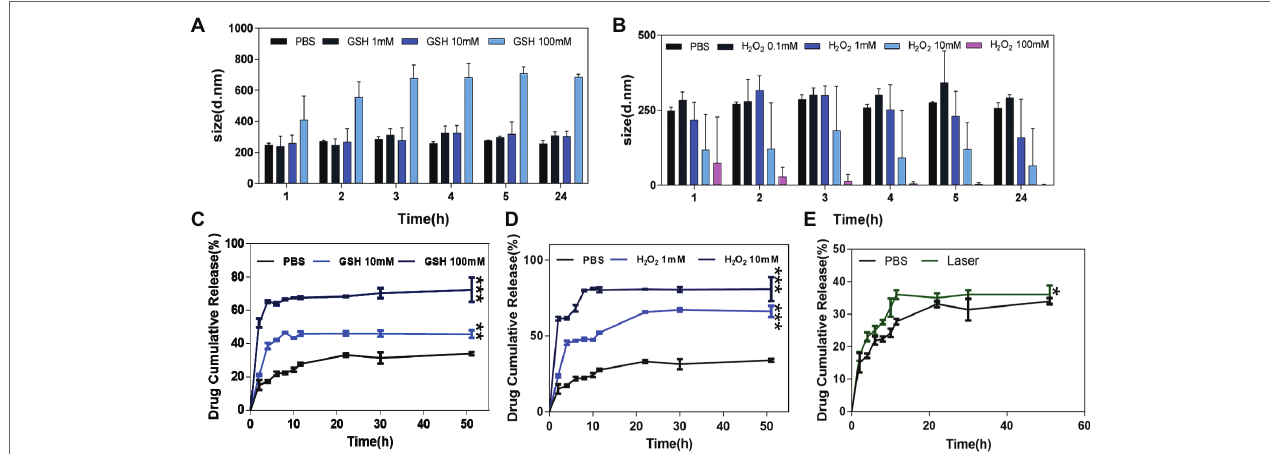
FIGURE 1 | The size change and Ce6 release behavior of HA-sese-Ce6 micelles in different concentrations of GSH and H 2 O 2 . (A) The size of HA-sese-Ce6 micelles in PBS, 1 mM GSH, 10 mM GSH, 100 mM GSH, respectively. (B) The size of HA-sese-Ce6 micelles in PBS, 0.1 mM H 2 O 2 , 1 mM H 2 O 2 , 10 mM H 2 O 2 , 100 mM H 2 O 2 , respectively. (C) The Ce6 release of HA-sese-Ce6 micelles in PBS, 10 mM GSH, 100 mM GSH. (D) The Ce6 release of HA-sese-Ce6 micelles in PBS, 1 mM H 2 O 2 , 10 mM H 2 O 2 . (E) The Ce6 release of HA-sese-Ce6 when exposed to a 650 nm laser (20 mW/cm 2 ) and PBS without laser treatment (the control group). The data are mean ± SD, p * ≤ 0.05, ** ≤ 0.01, *** ≤ 0.001 vs. the